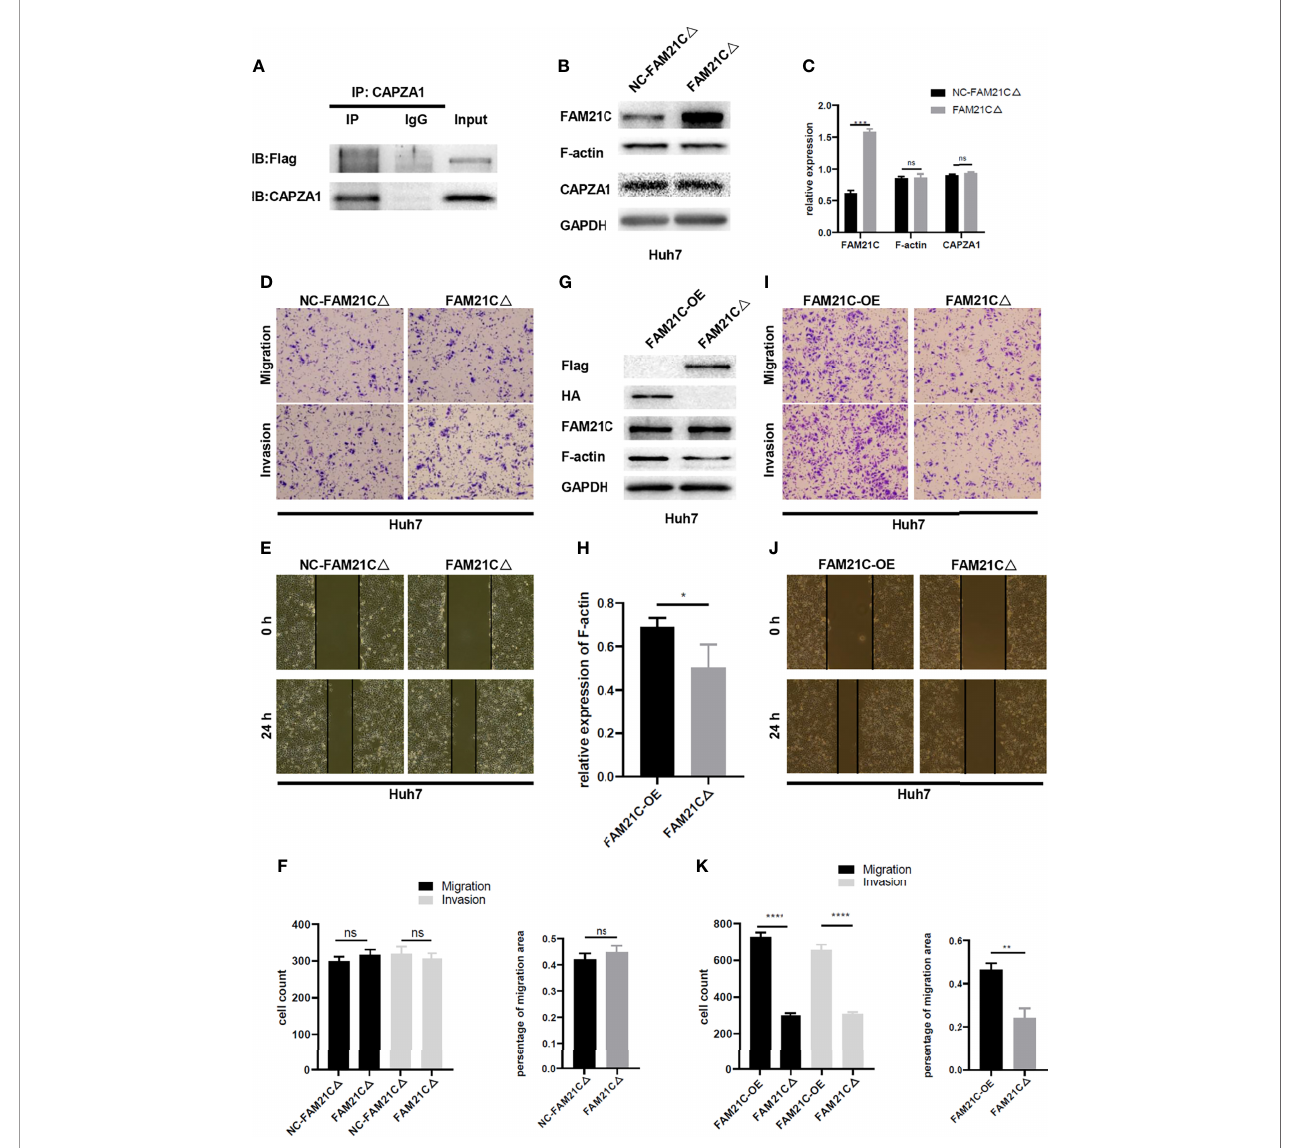
FIGURE 5 | FAM21C CPI mutation failed to promote the HCC cells invasion and migration. (A) Co-IP was used to validate the interaction between FAM21C mutation and CAPZA1. The results showed that CPI mutation interfered with binding to CAPZA1. (B) Western blotting was performed to detect the expression level of FAM21C, CAPZA1 and F-actin following transfected with mutation lentivirus in Huh7 cells. (C) Histograms showed the relative expression level. (D, E) Transwell, Wound healing, and invasion assays were performed to validate the migration and invasion potential of CPI mutation Huh7 cells. (F) Histograms showed the results were of no signi fi cant. (G) The protein of Flag, HA, FAM21C, F-actin, GAPDH were analyzed by western blotting. (H) Histograms showed the relative expression levels of F-actin. (I, J) Transwell, Wound healing, and invasion assays were performed to validate the migration and invasion potential of FAM21C-OE-Huh7 and FAM21C D -Huh7 cells. (K) The statistical graph indicates the cell count and percentage of the migration area. Data are represented as the mean ± SD, n=3. * P < 0.05, ** P < 0.01, *** P < 0.001, **** P < 0.0001; ns for no signi fi